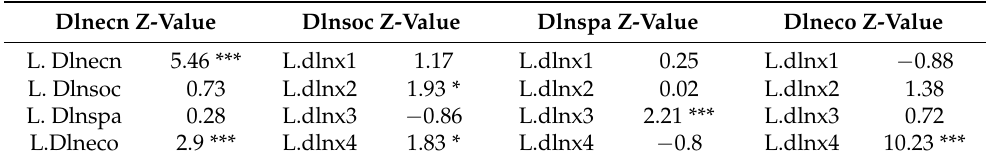
Table 4. GMM estimation